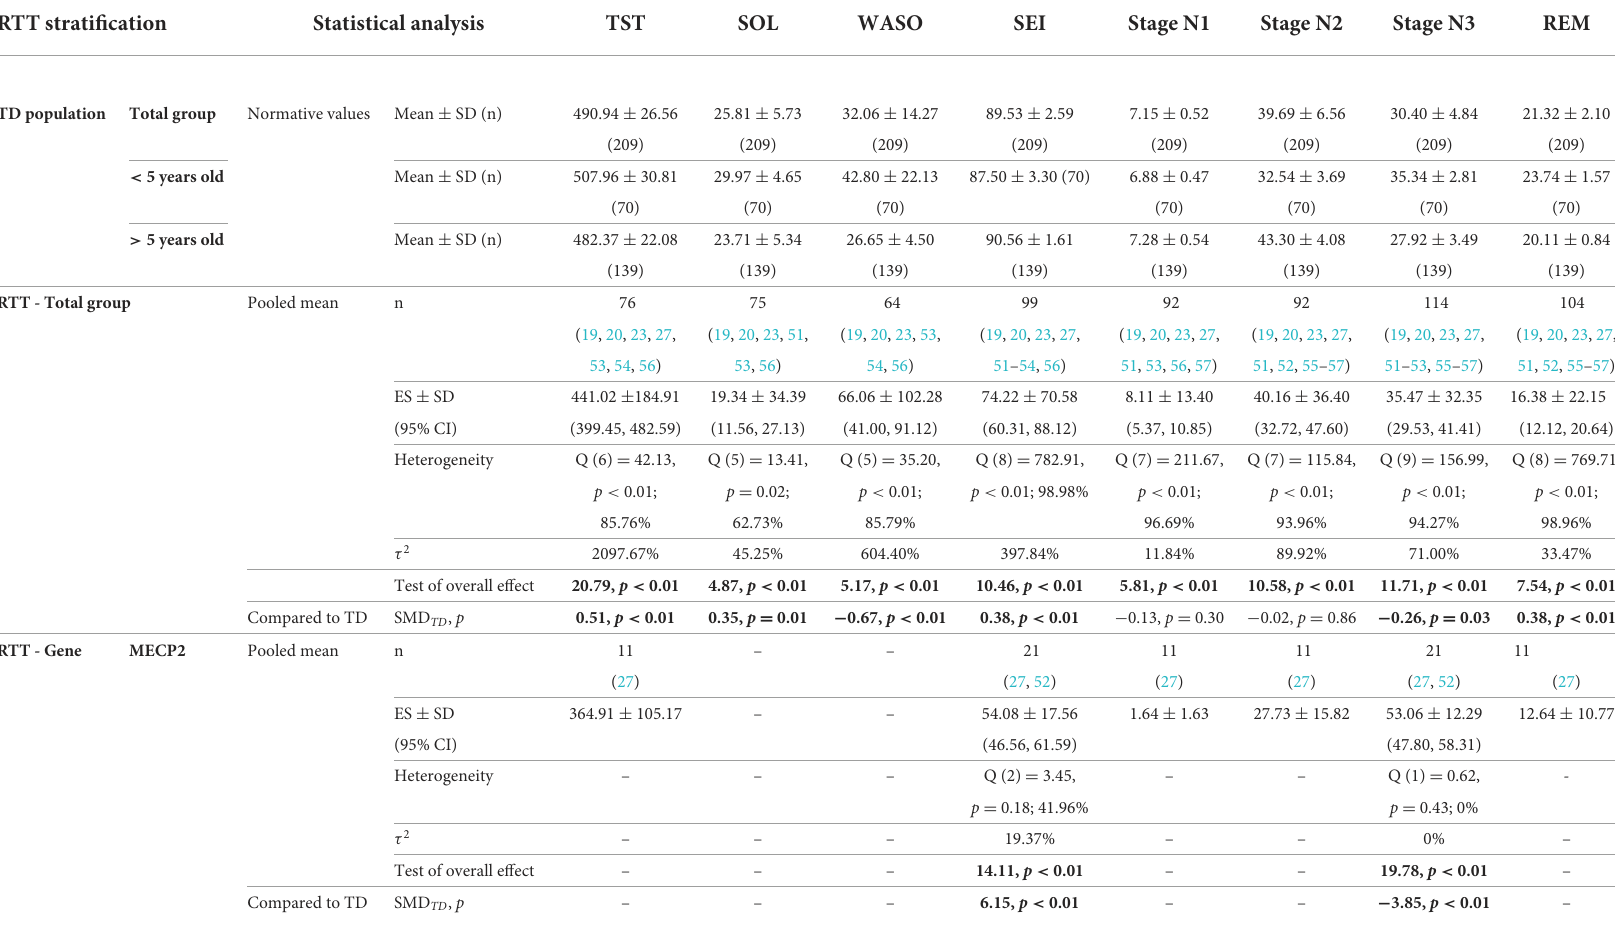
TABLE 3 Pooled mean of sleep macrostructure in RTT subjects and the comparison with literature normative values for typically developing population (49) (Part 1). RTT stratification Statistical